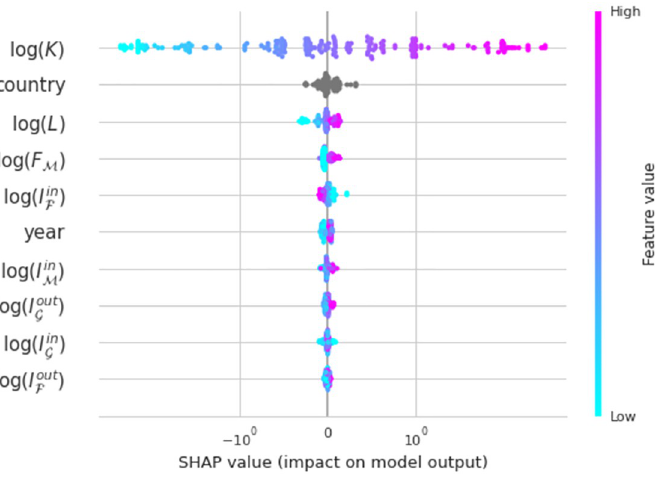
Fig 5. SHAP values for the different features in the Gradient Boosting Regressor. We observe that capital and country effects are the most important features, however the rest of them also contribute to the model estimates.